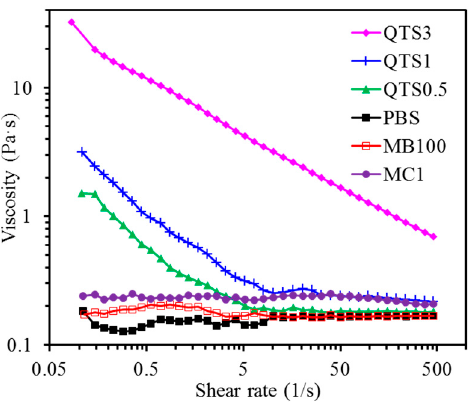
Figure 2. The viscosity changes of various solution samples under different shear rates.